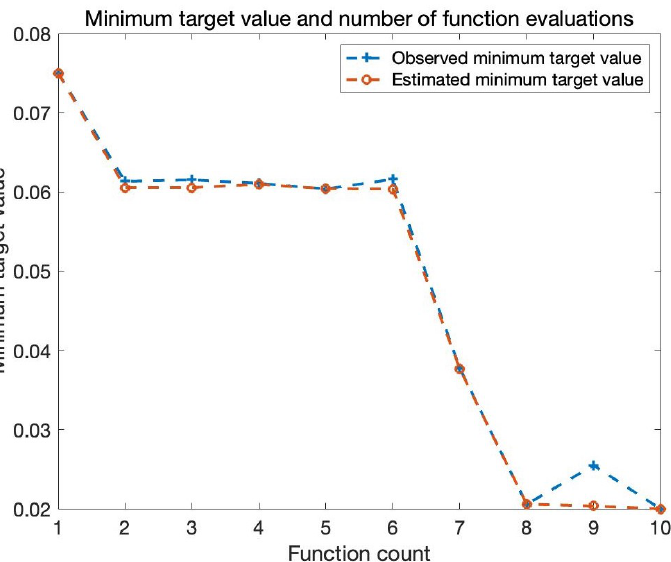
Figure 11. Flowchart of the proposed Bayes-Bi-LSTM.